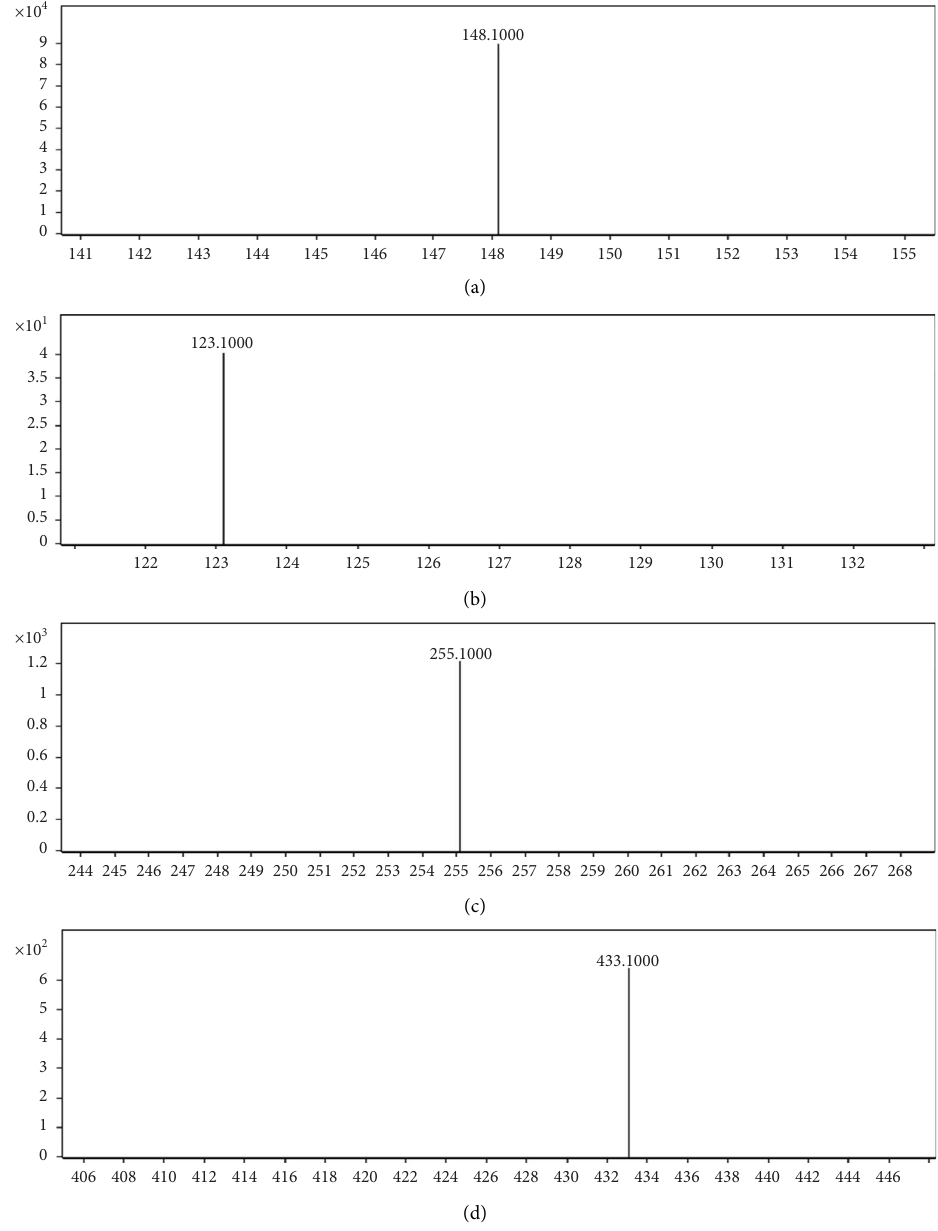
Figure 3: Te product ion mass spectra of positive and negative ions of ephedrine (a), gastrodin (b), liquiritin (c), and I.S.